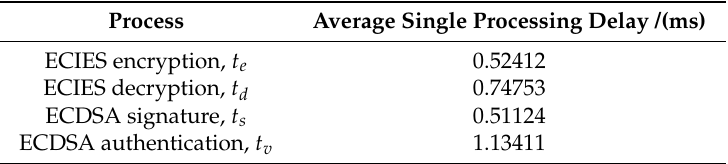
Table 5. Delay of traditional encryption and decryption